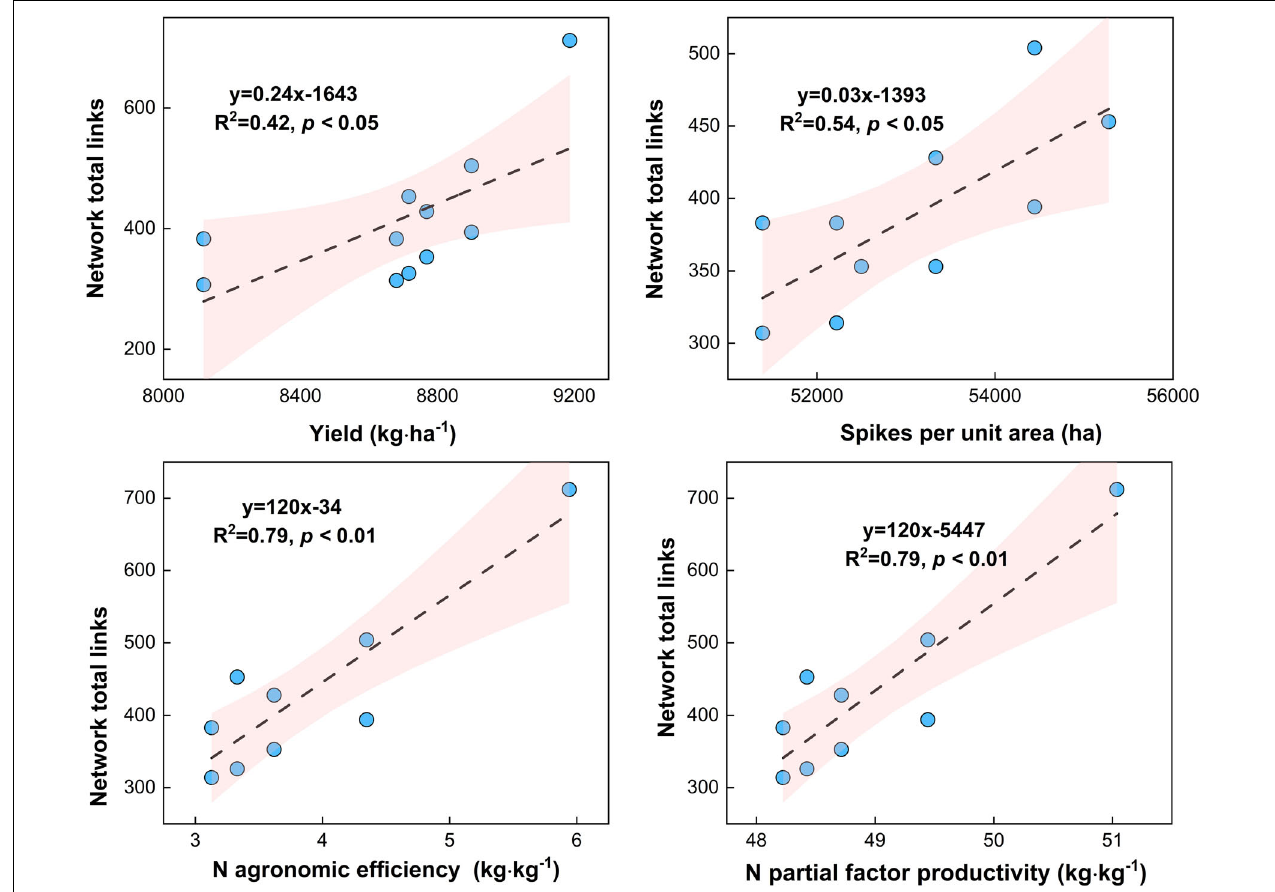
FIGURE 8 | Overview of bacterial networks in the rhizosphere soil at the maize physiological maturity stage under different N fertilizer treatments (including CT, U, S, SU3, SU5, and SU7), with node size proportional to node connectivity. Node color represents various phylogenetic phyla. TABLE 1 | Network topological characteristics in rhizosphere soils and bulk soils at the maize silking stage under different N fertilizer treatments. Topological